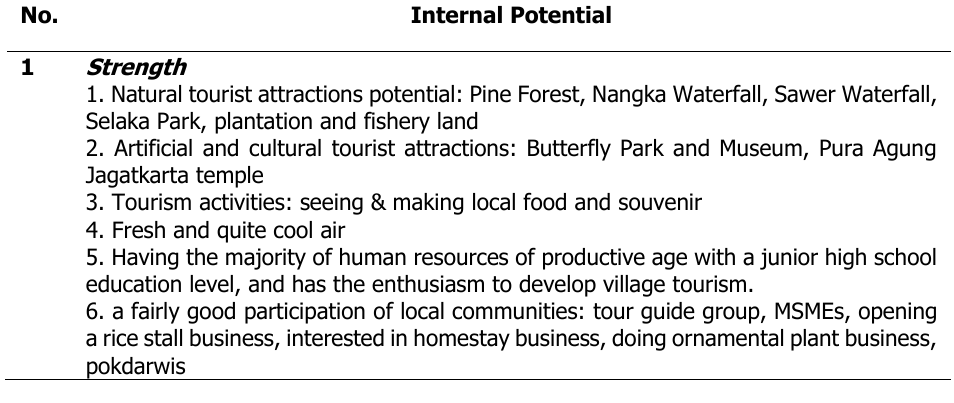
Table 3. SWOT Analysis of Sukajadi Tourism